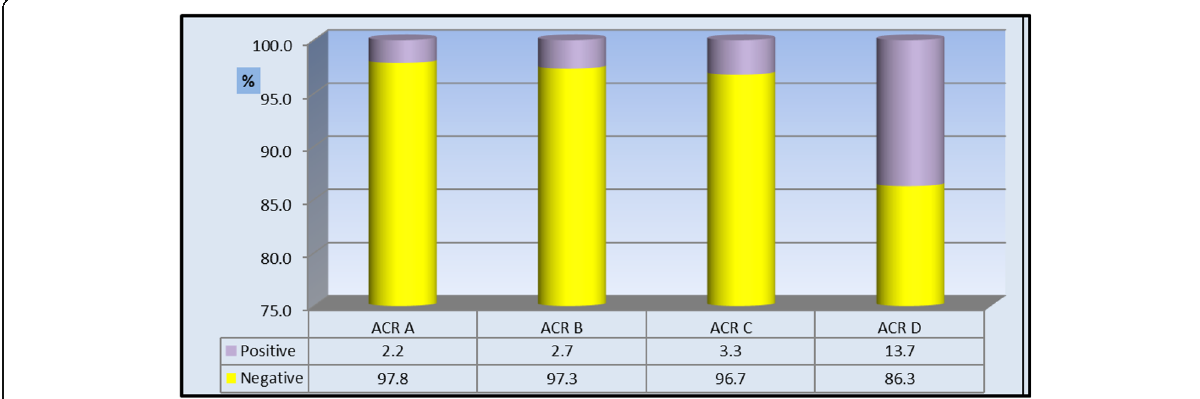
Fig. 2 Frequency of breast cancer as regards different mammographic densities